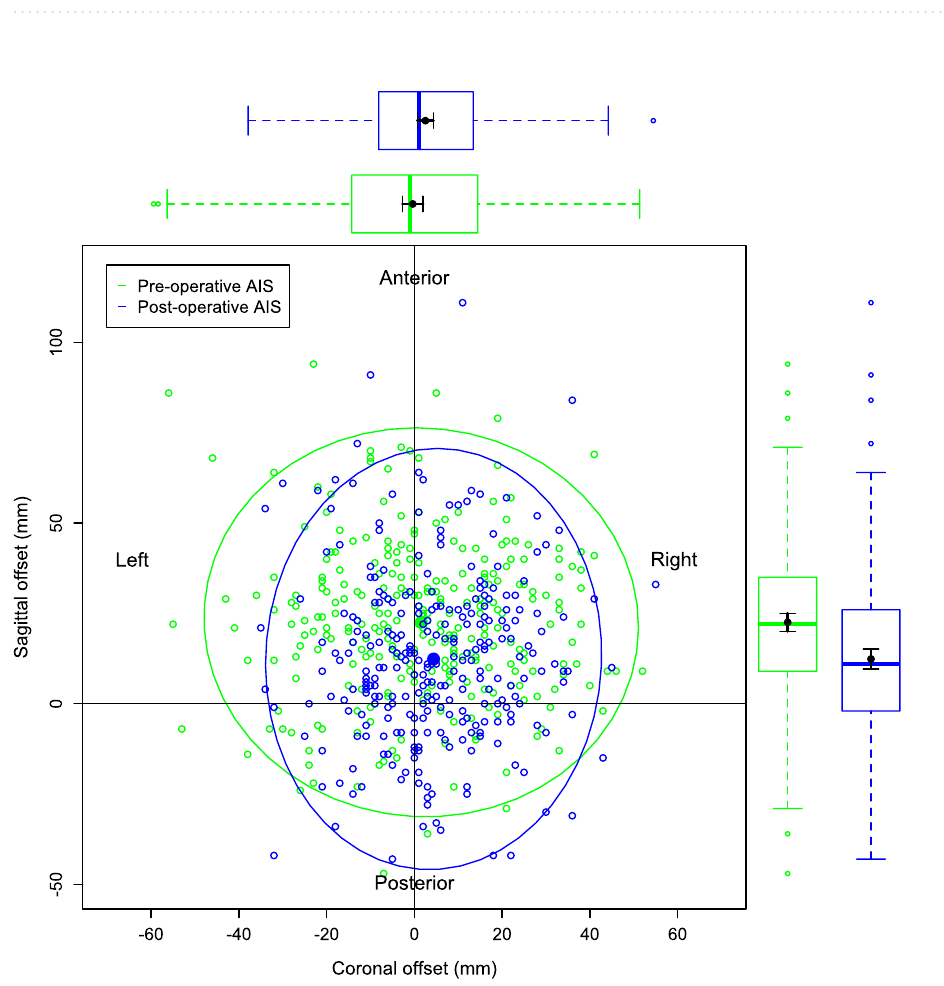
Figure 4. The individual data points, mean values and 95% confidence ellipses for the pre and post-operative AIS groups. The box and whisker plots demonstrate the data of the equivalent parameter in that group. The plot shows the data from a ‘bird’s eye’ position with anatomic descriptors of ‘Anterior’, ‘Posterior’, ‘Left’ and ‘Right’ as